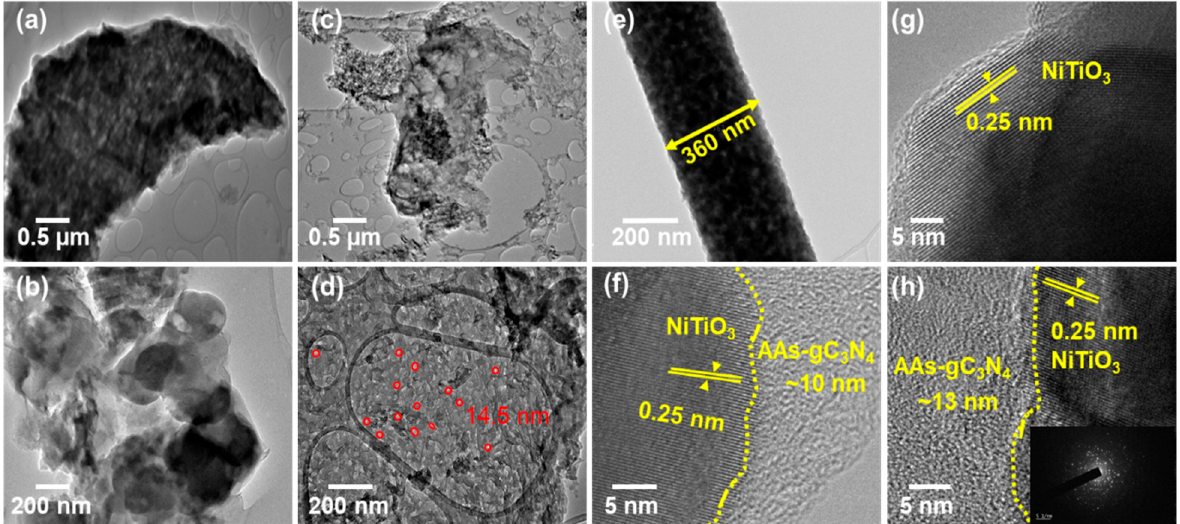
Figure 2. Transmission electron microscopy (TEM) images of the prepared samples. ( a , b ) Bulk gC 3 N 4 , ( c , d ) AAs-gC 3 N 4 at low and high magnifications, respectively, red circles show pores in the structure with an average size of 14.5 nm ( e , g ) low and high magnification TEM images of NiTiO 3 NFs. ( f , h ) high magnification TEM images of gnT4060 and gnT6040 respectively.